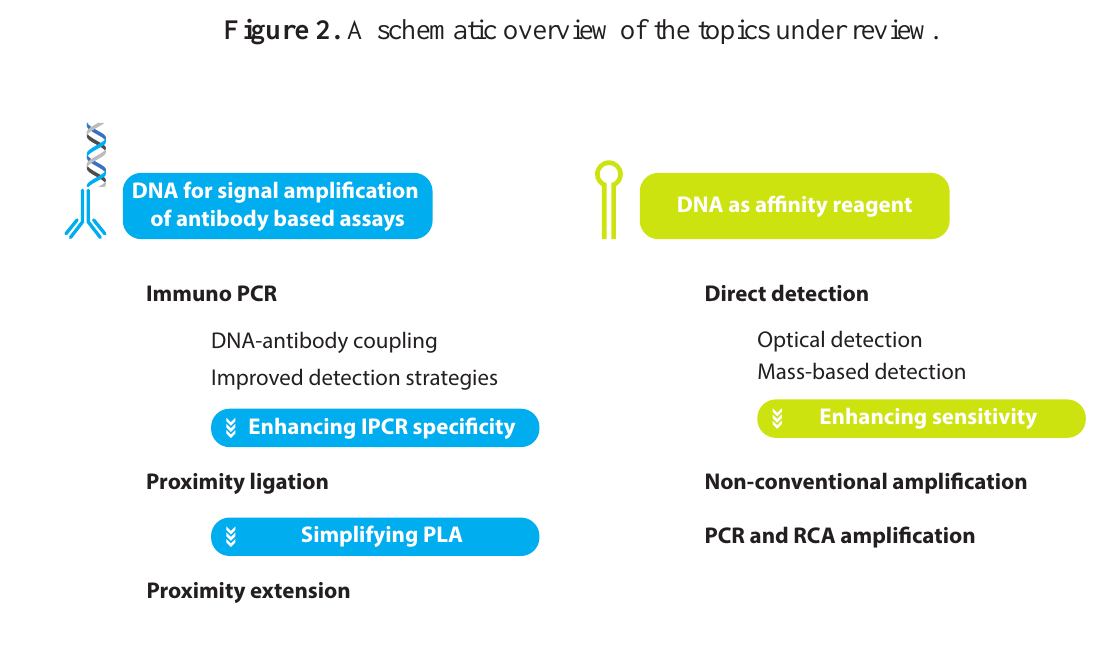
= Signal generation